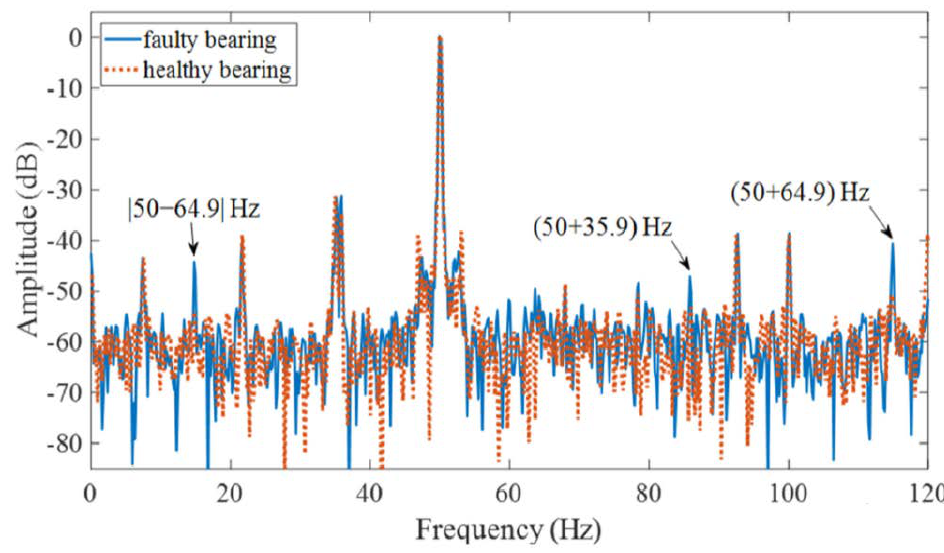
Figure 17. The waveform of the stator current in the frequency domain for healthy and faulty bearings. Reproduced with permission of [51].